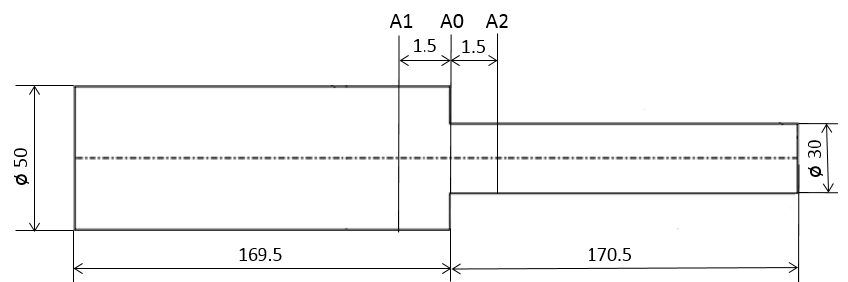
Figure 7. Model geometry and location of control sections. Dimensions are given in mm.